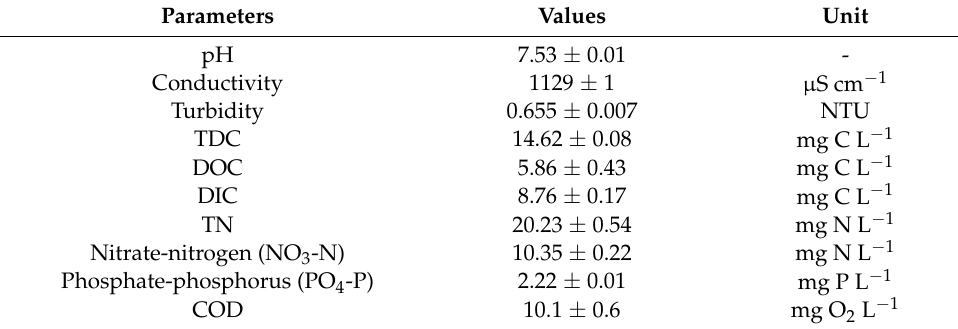
Table 1. Characterisation of the aquaculture effluent used in this